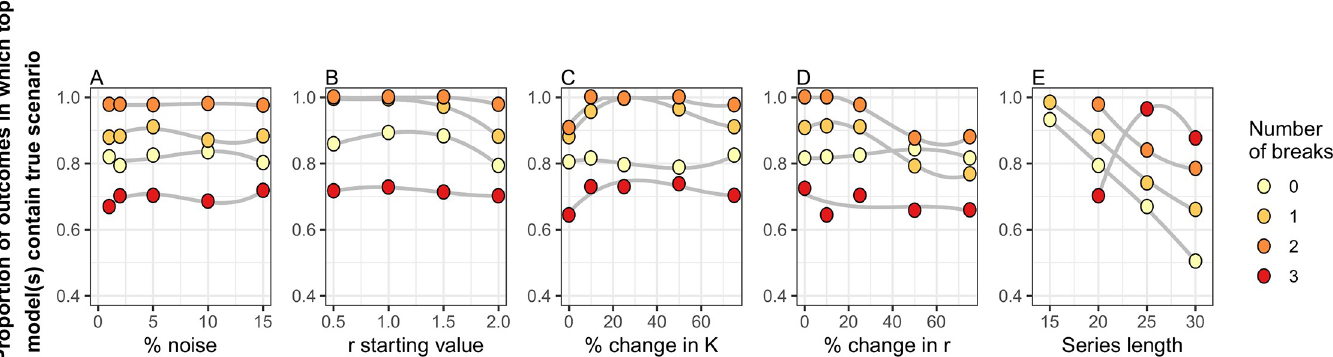
Fig 1. Performance of the Dynamic Shift Detector (DSD) algorithm under varying parameter values. Proportion of simulation results in which the true break scenario was detected within the top break point combinations as identified by the DSD implemented with an underlying Ricker model with varied A) noise (in the form of normally distributed error), B) starting values of the r parameter, C) percent changes in the K parameter, D) percent changes in r , and E) simulated time series length. Sets of 0, 1, 2 and 3 break points were randomly generated from within the set of possible values, and 250 datasets were simulated for each scenario. In each panel, other variables (that were not being varied) were held constant at their base values (i.e., noise = 2%; starting value of r = 2; change in r = ± 25%; change in K = ± 75%; time series length = 20 years). Trends within a set of scenarios (grey lines) are illustrated with a third-order GAM smoothing line.